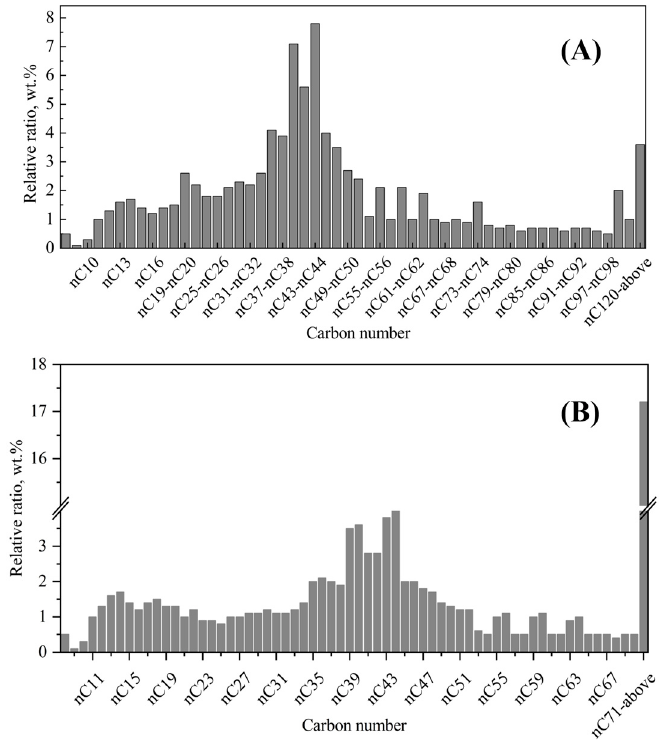
Figure 4. Carbon number distributions of the ( A ) crude oil and ( B ) wax deposit.